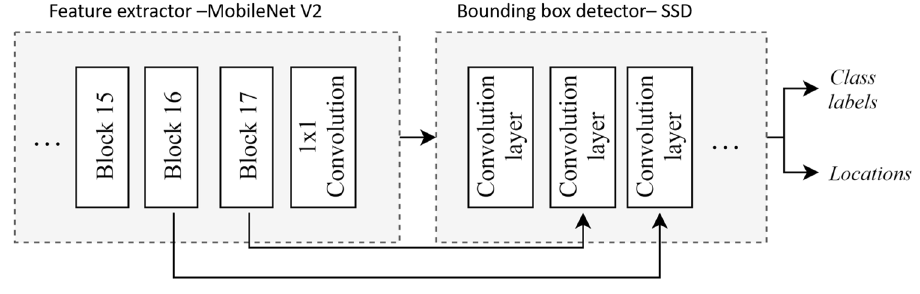
Figure 2. SSD MobileNet